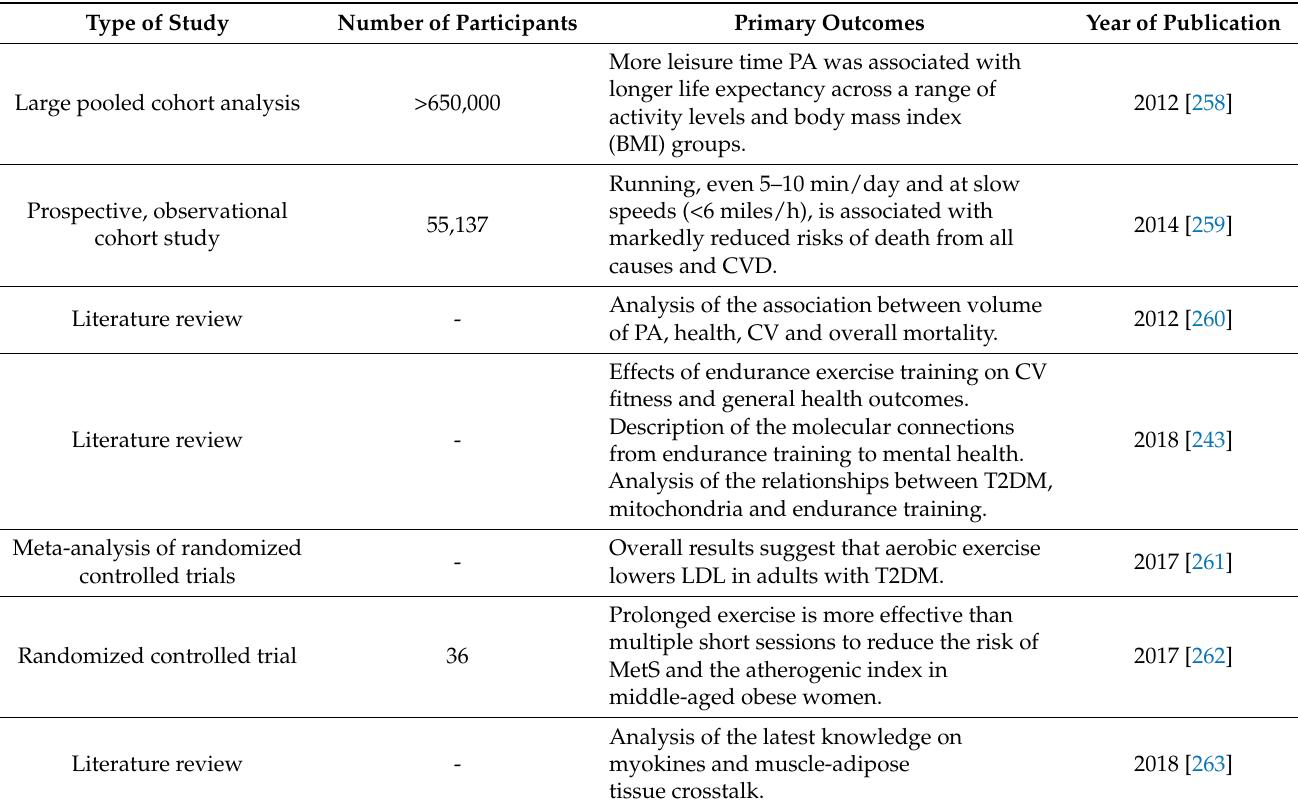
Table 5. Characteristics of studies describing the effects of physical activity on